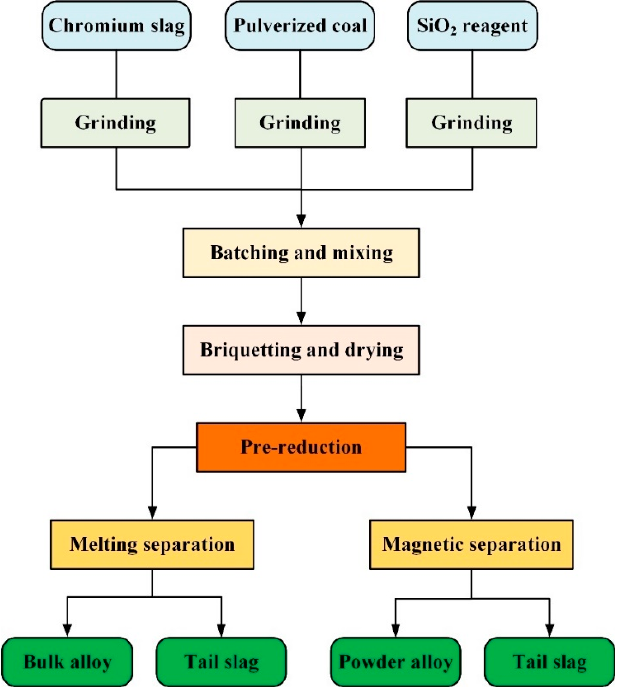
Figure 2. Experimental procedures for the pre-reduction and separation processes.